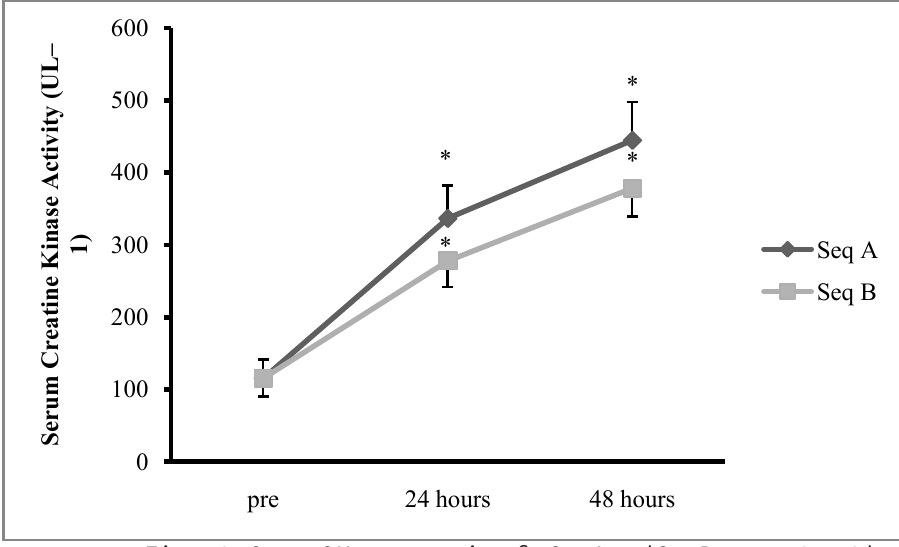
Figure 2. Serum CK concentrations for Seq A and Seq B at pre, 24, 48 hours. *Significant difference in pre-CK concentration at Seq A and Seq